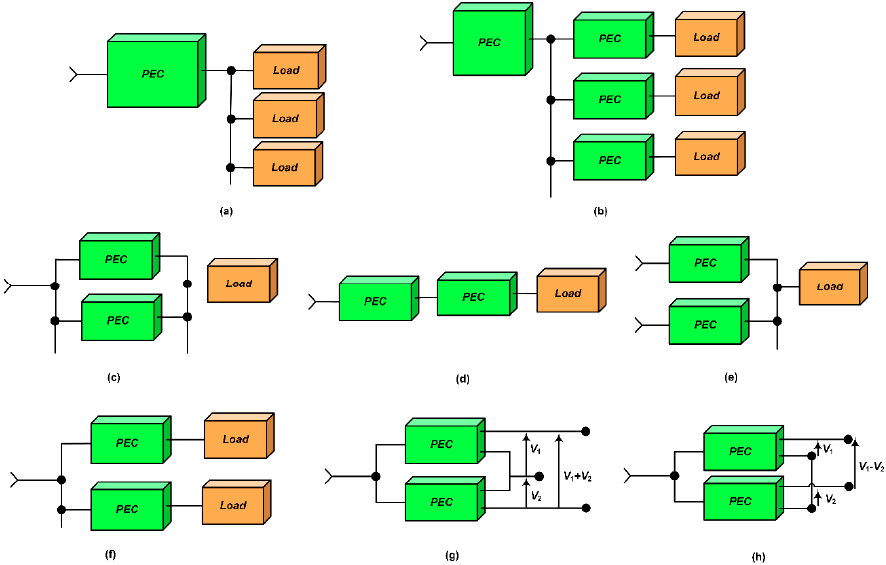
Figure 2. Power architectures: ( a ) centralized; ( b ) distributed. Distribution configurations: ( c ) parallel; ( d ) cascading; ( e ) source splitting; ( f ) load splitting; ( g ) sum stacking module; ( h ) difference stacking module.